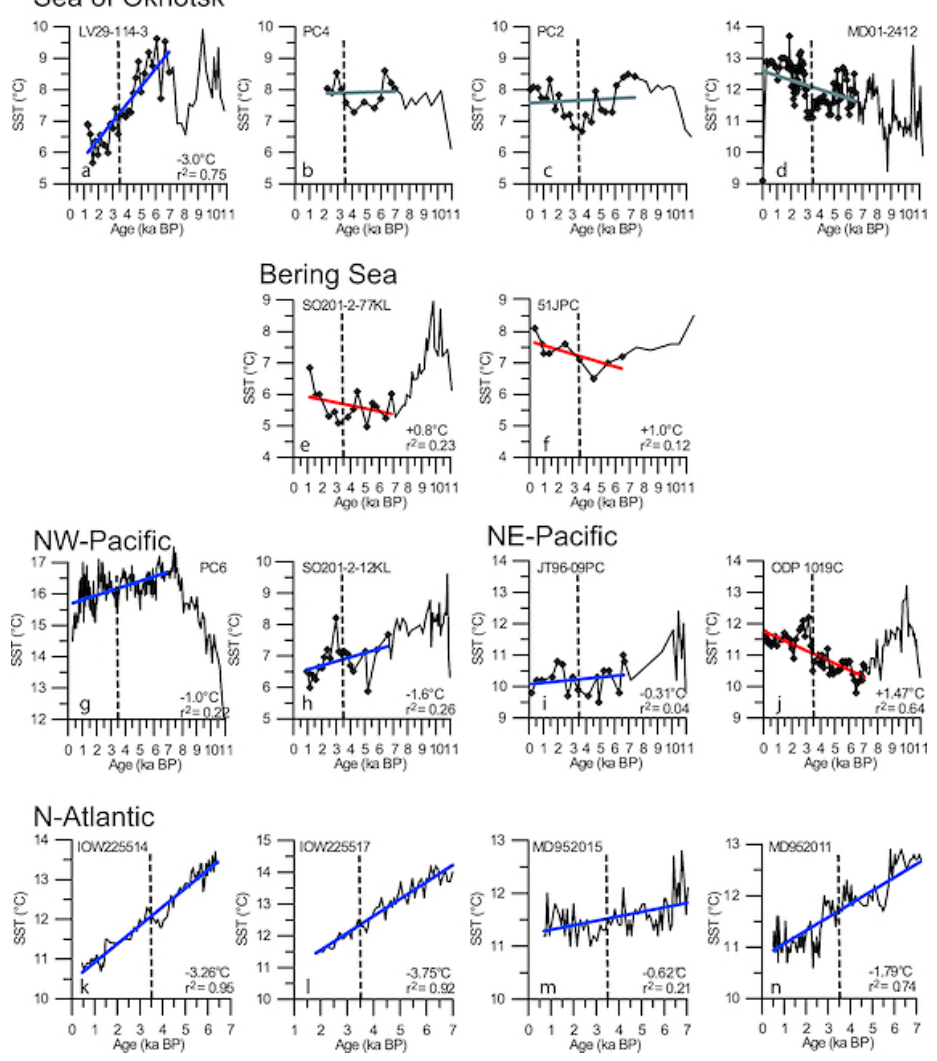
Figure 7. Compilation of alkenone-based SST reconstructions from the North Pacific region ordered according to source for the Holocene period. Lines indicate linear regressions over the last 8 ka, blue = cooling trend, red = warming trend [81].